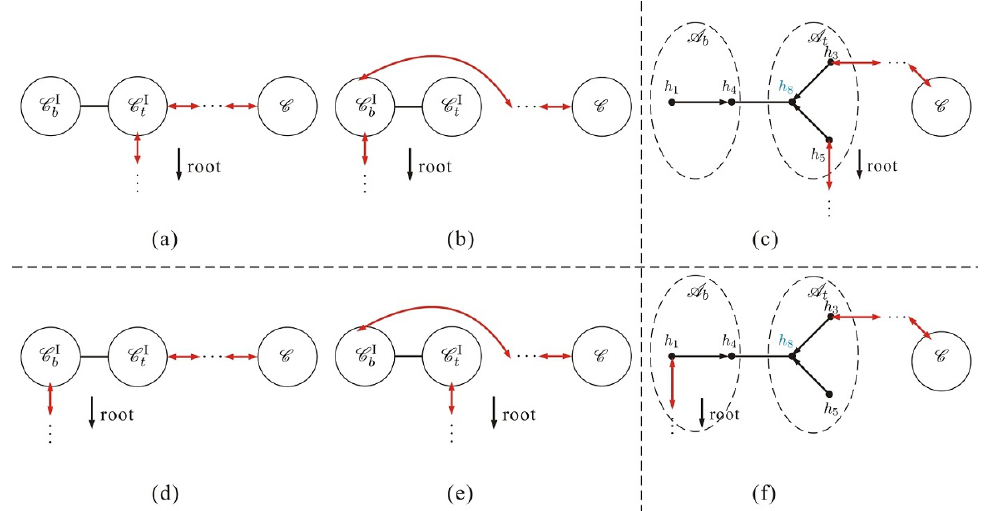
Figure 12 . Assume that C is the type-II component or a type-I component with a higher weight than C I . The graphs (a) and (b), in which a higher-weight chain passes through only one side of C I , are not allowed by the re(cid:12)ned graphic rule because a chain cannot contain con(cid:13)ict arrow